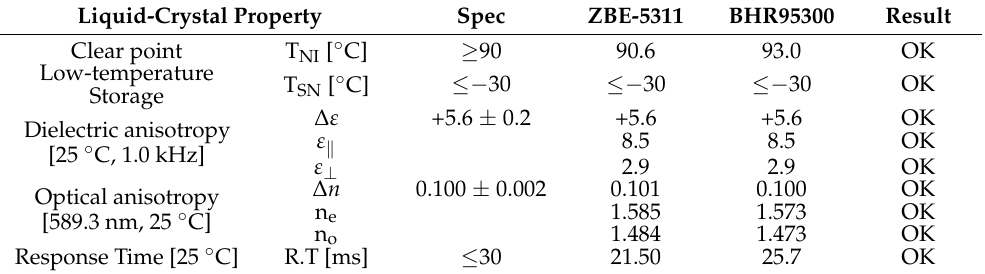
Table 6. Elastin Constant and γ 1. Liquid-Crystal Property Spec ZBE-5311 BHR95300 Result K 11 Elastic constant [25 ◦ C]